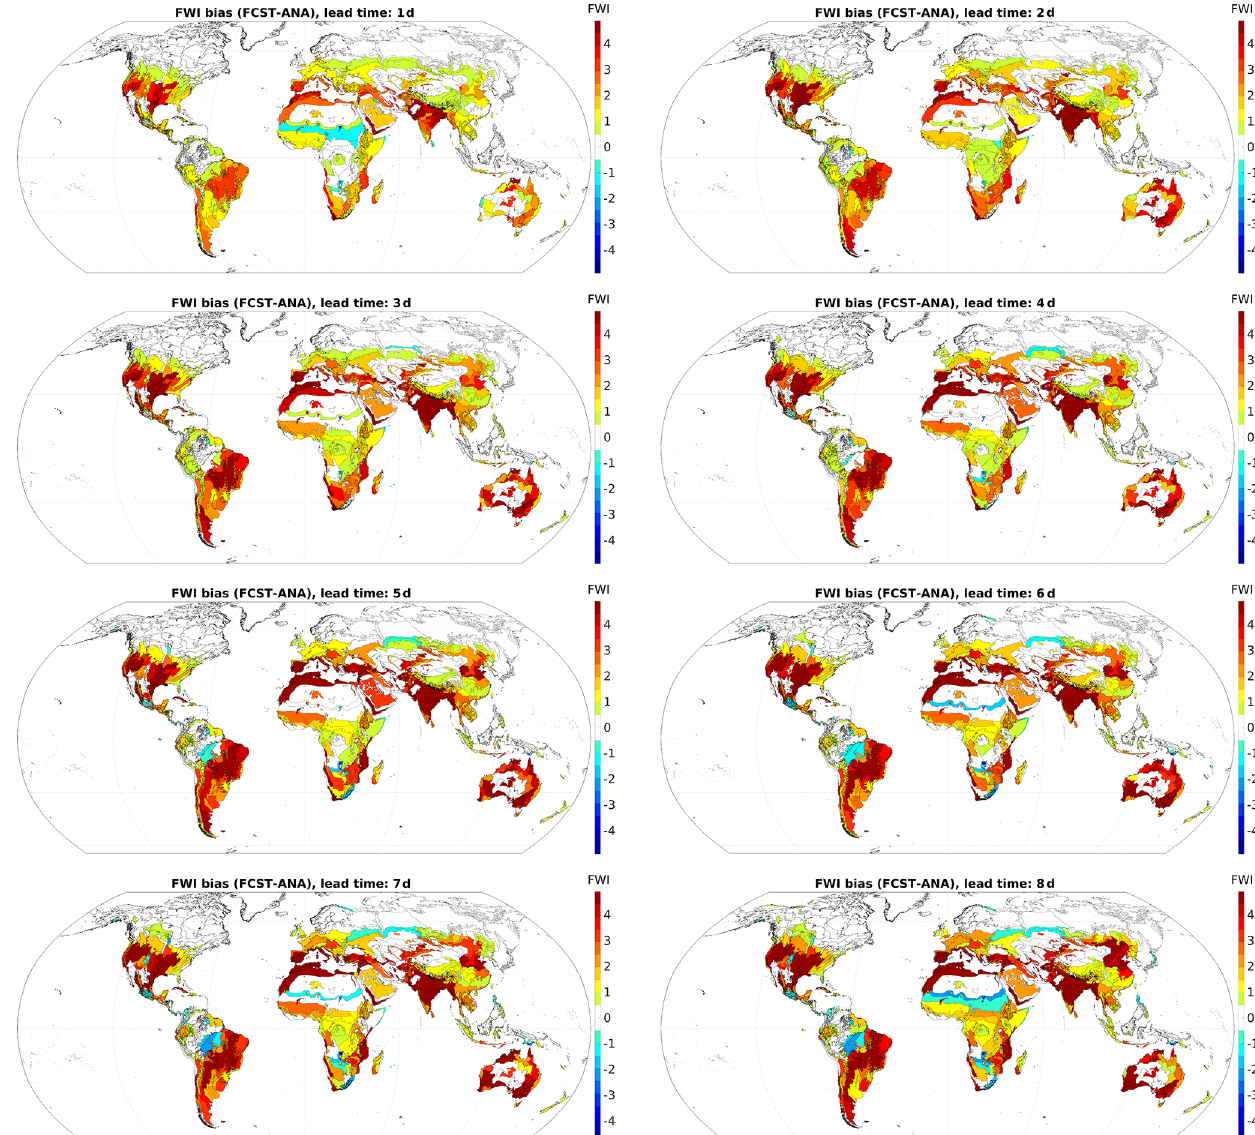
Figure 13. Same as Fig. 11 but for the FWI bias (forecast analysis –